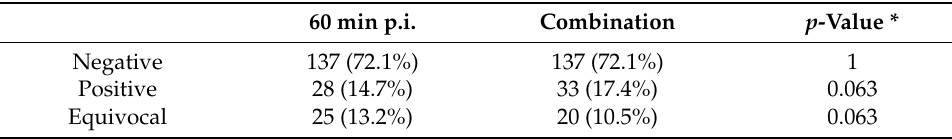
Table 3. Comparison of the 60 min p.i. vs. a combination of